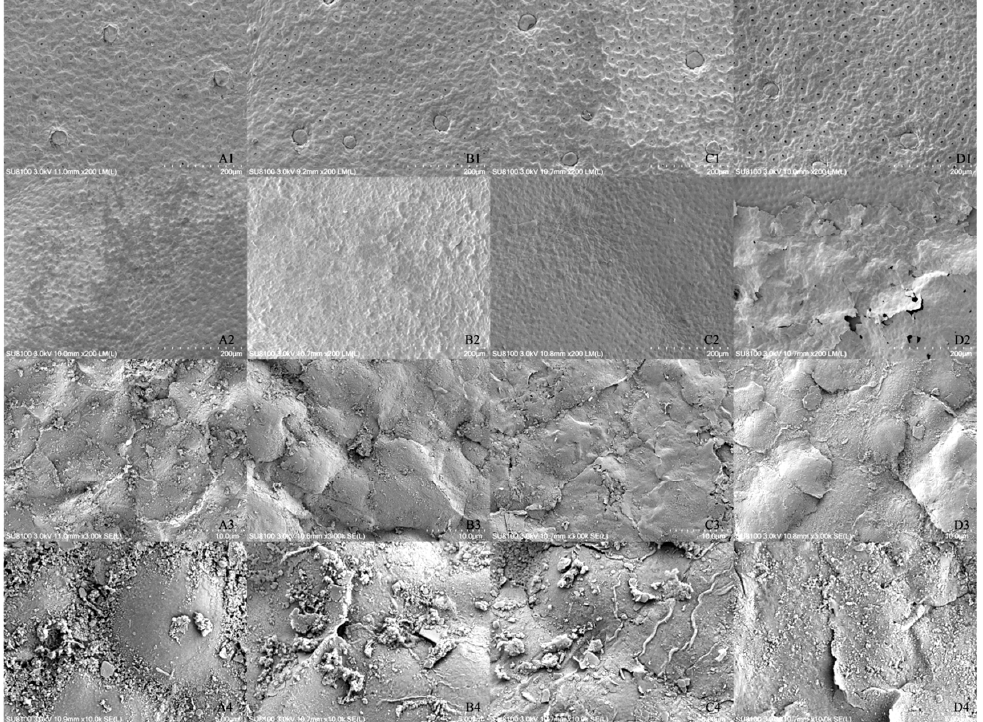
Figure 3. The effect of enhanced UV-B radiation on stomatal and surface microstructures in leaves. Note: ( A1 – A4 ). 2.7 CK; ( B1 – B4 ). 2.7 enhanced UV-B radiation; ( C1 – C4 ). 2.17 CK; ( D1 – D4 ). 2.17 enhanced UV-B radiation. The same scheme applies to the figures